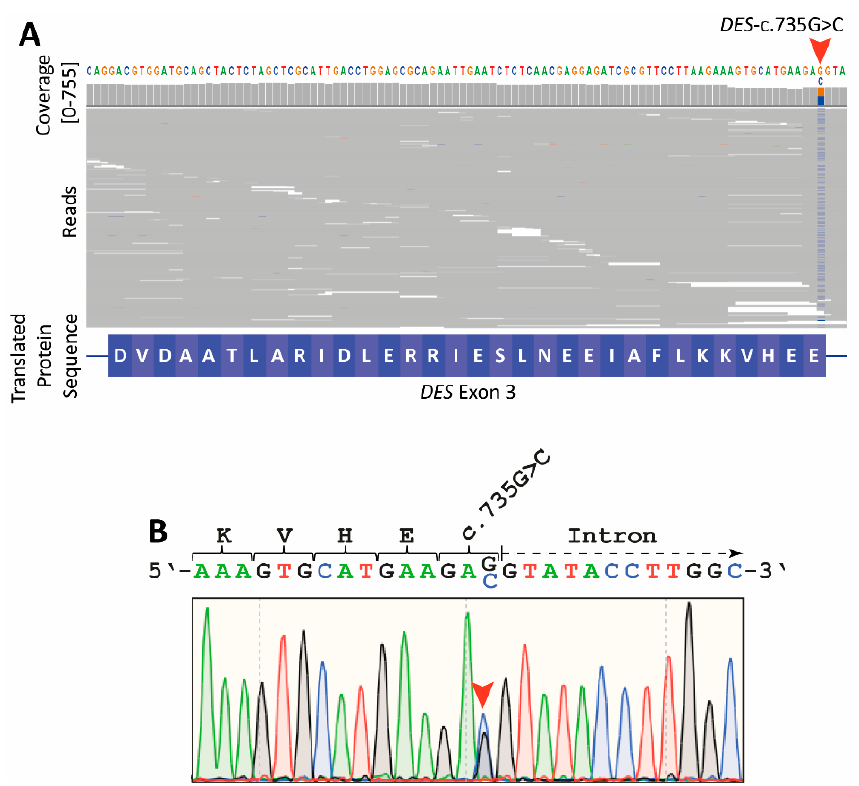
Figure 3. Genetic analysis of the index patient (III-9). ( A ) Integrated genome view of DES exon-3 revealed DES -c.735G>C in the gDNA from III-9 (red arrow). Cytosine was detected in 291 reads (53%, 131+, 160 − ), and guanosine was detected in 258 reads (47%, 119+. 139 − ). Reads are shown in grey. ( B ) Electropherogram of DES -c.735G>C generated by Sanger sequencing using gDNA from III-9 (red arrow). Of note, this missense mutation changes the last nucleotide in exon-3.